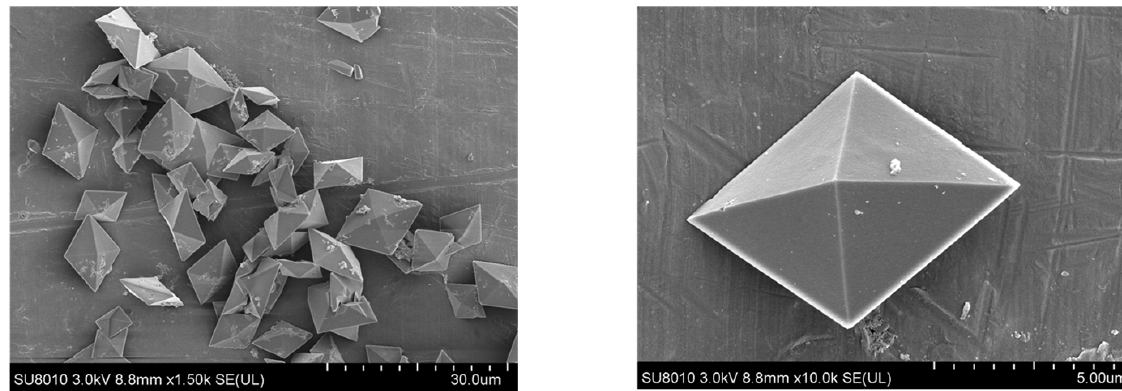
Figure 1. SEM images of the synthesized Zr-MOF-P .